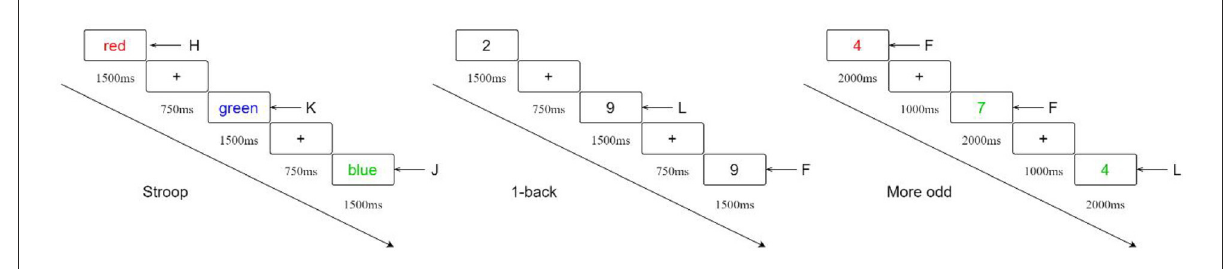
FIGURE3 Schematic diagram of task